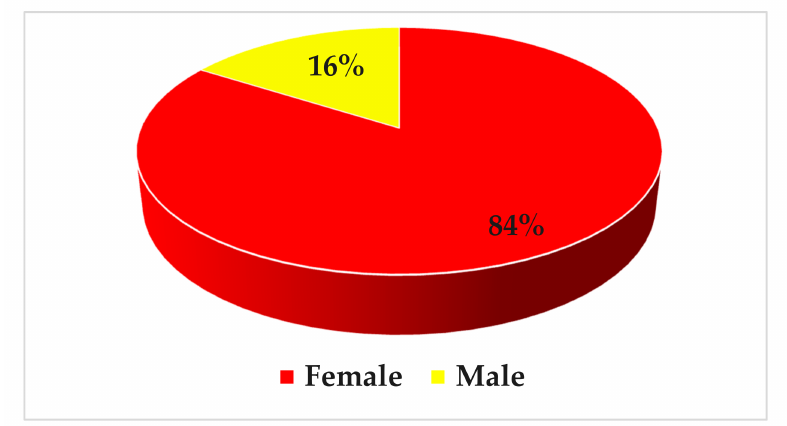
Figure 5. Characteristics of the respondent based on gender.